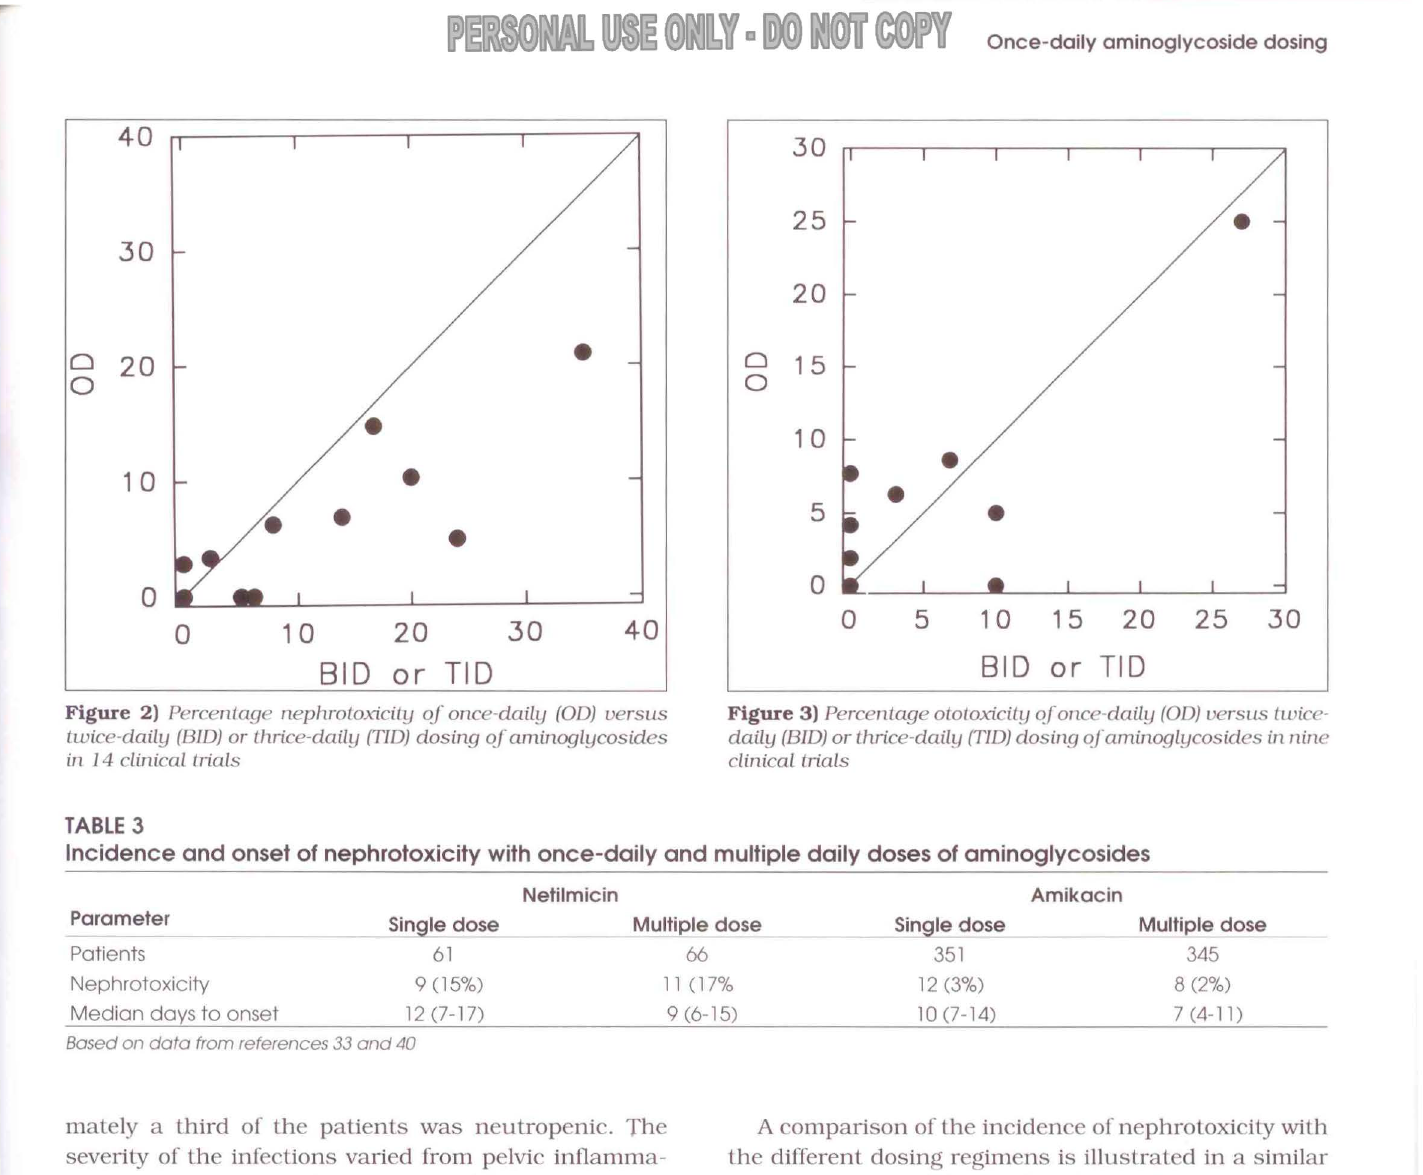
Figure 3) Percentage otoloxicity of once-daily (OD) versus twice daily (BID) or thrice-daily (TIDJ dosing of aminoglycosides in nine clinical